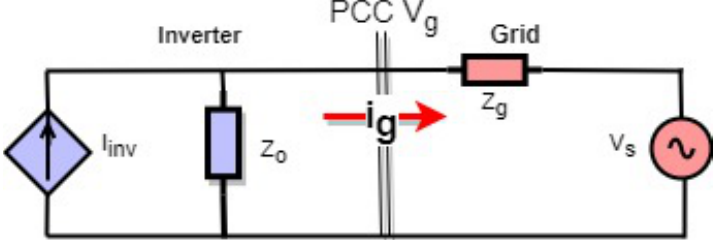
Figure 6. Norton and Thevenin models of inverter and grid in grid tied